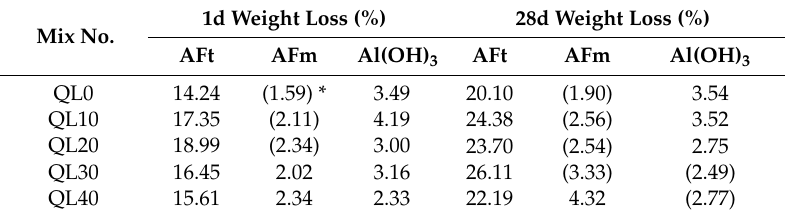
* data in ( ) means no endothermic peak appeared.